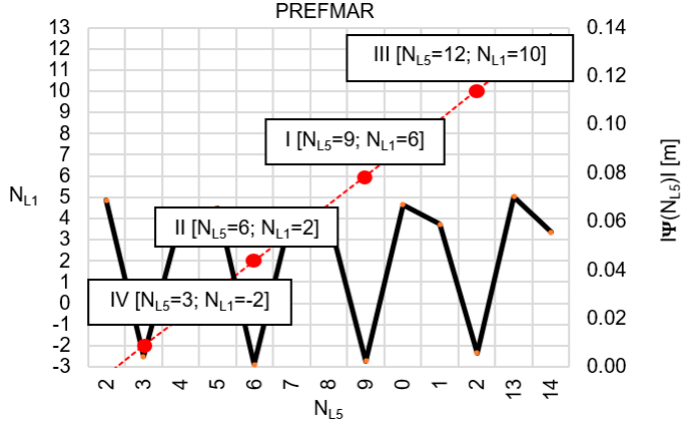
Figure 10. Search area of ambiguities in 𝑁 (cid:3013)(cid:2873) 𝑁 (cid:3013)(cid:2869) system, for 𝑁(cid:3561) (cid:3013)(cid:2873),(cid:2868) = 8.349 and 𝑁(cid:3561) (cid:3013)(cid:2869),(cid:2868) = 5.141 , with